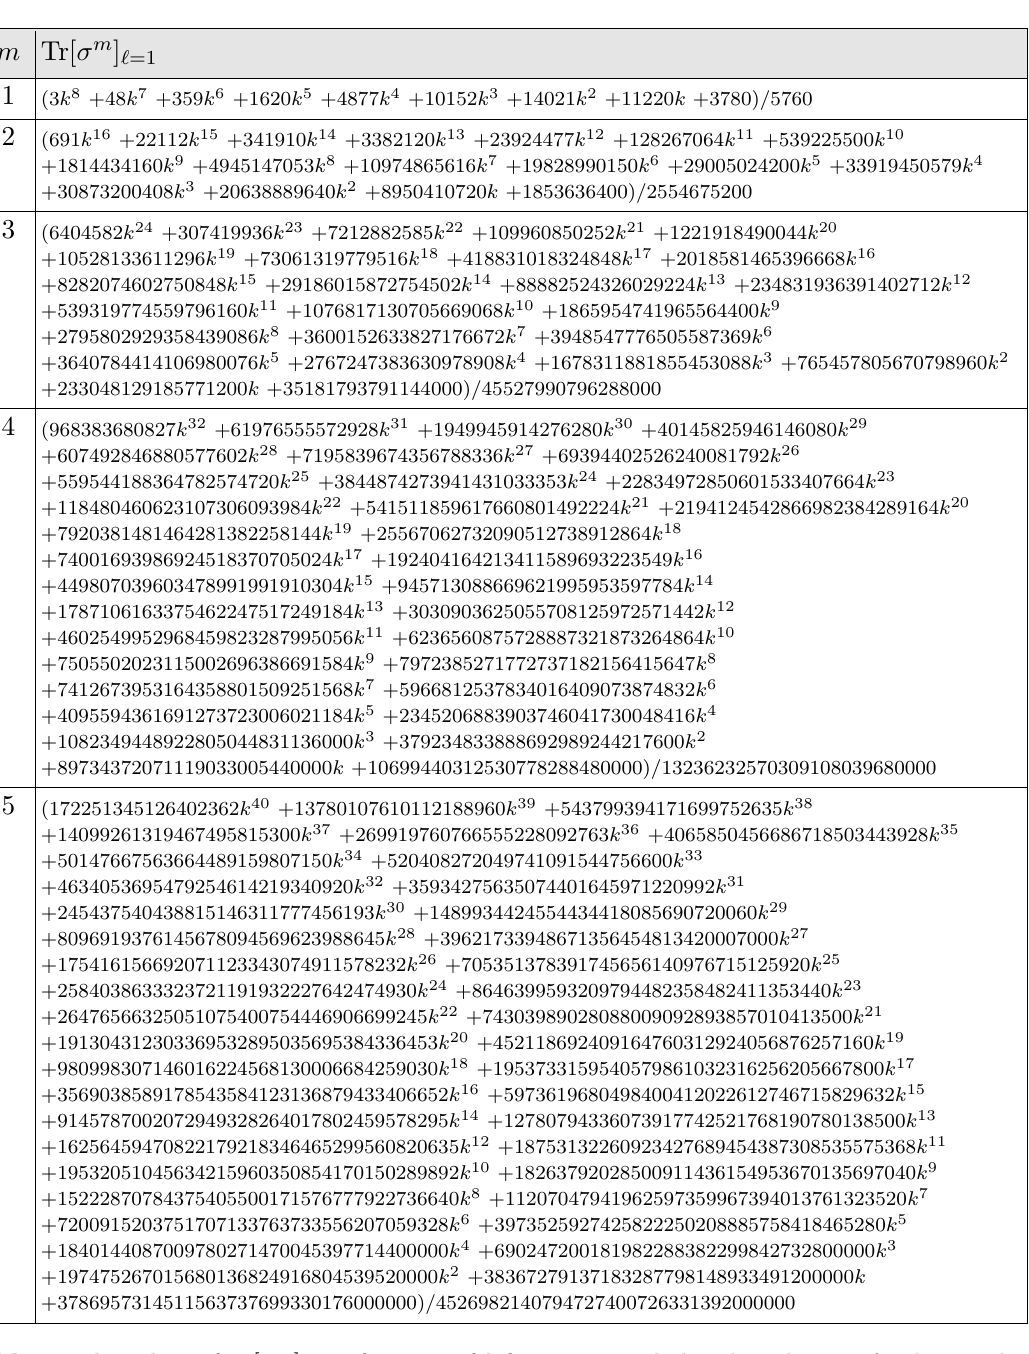
Table 5. The values of Tr [ σ m ] as a function of k for T 4 , 8 torus link. The subscript ‘ indicates that the polynomial is valid for k ≡ ‘ ( mod 2)